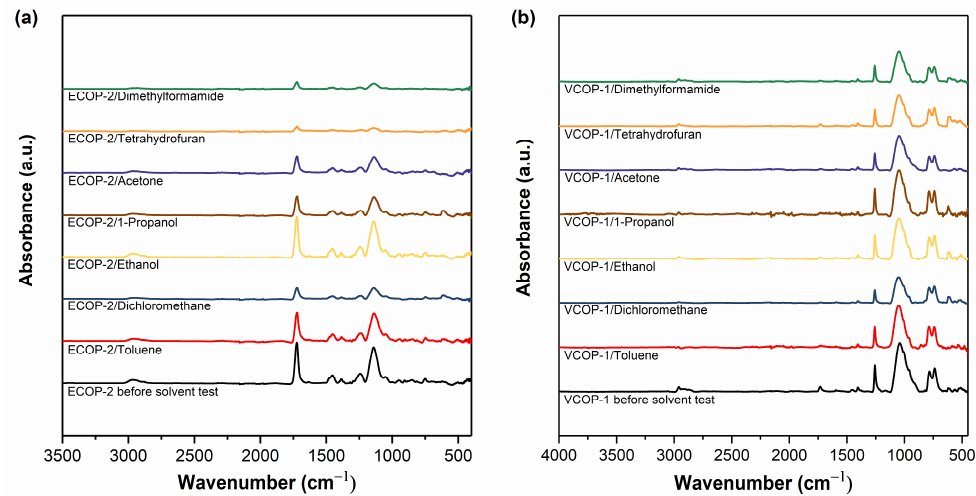
Figure 6. FTIR spectra of ( a ) ECOP-2 and ( b ) VCOP-1 copolymers before and after immersion in organic solvents.